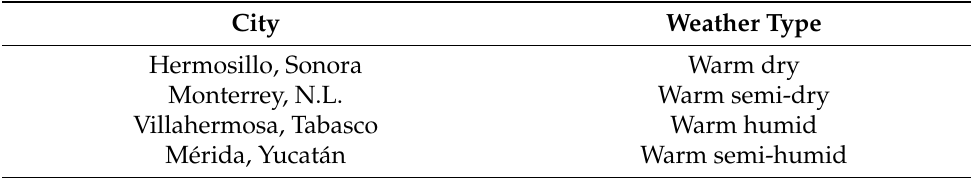
Table 1. Representative cities of the zones with warm weather in